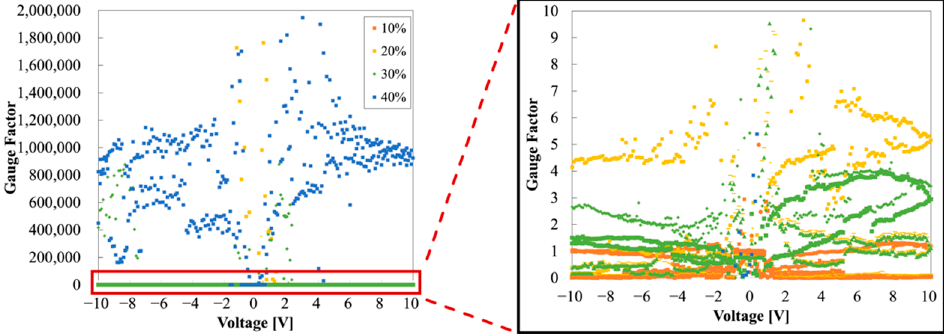
Figure 12. Overall GF of Sample B ( left ) and enlarged GF of Sample B ( right ).